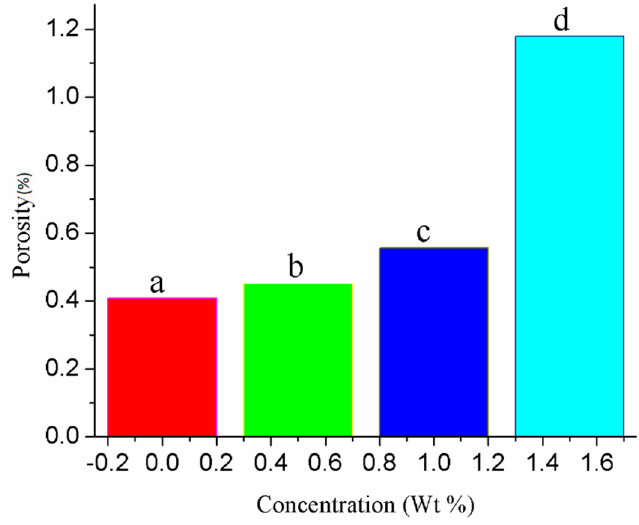
Figure 5. Porosity of Au (0.0, 0.5, 1.0 and 1.5 wt %)-doped ZnO–Sm nanoparticle films.